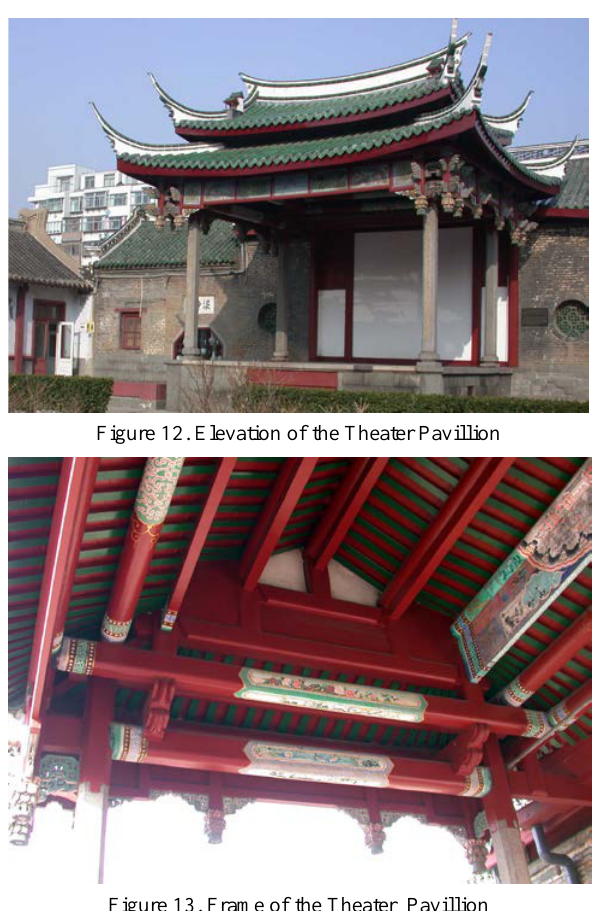
Figure 13. Frame of the Theater Pavillion